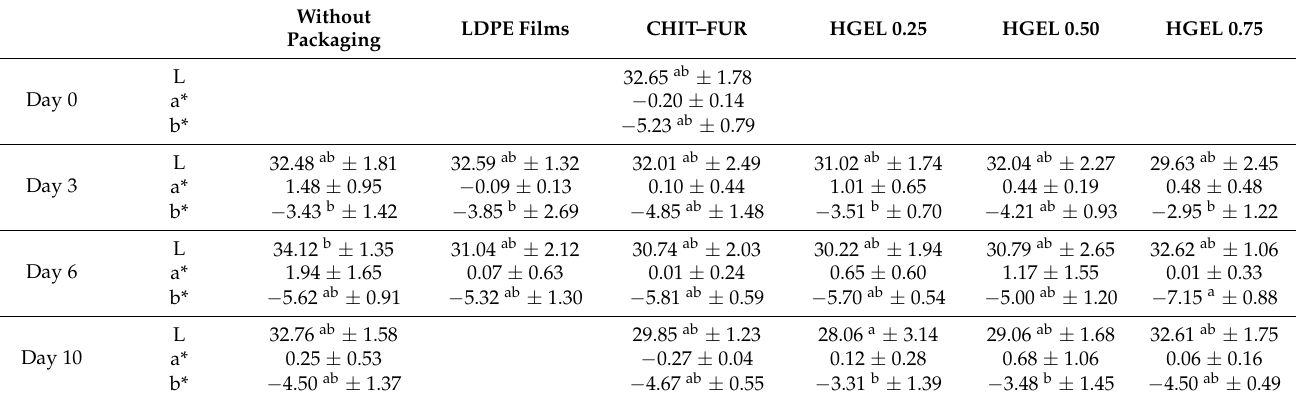
Table 4. The colour parameter of blueberries stored in different